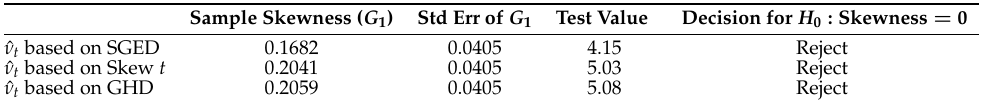
Table 3. Testing symmetry of empirical distribution of standardized residuals ˆ ν t using the skew- ness coefficient.